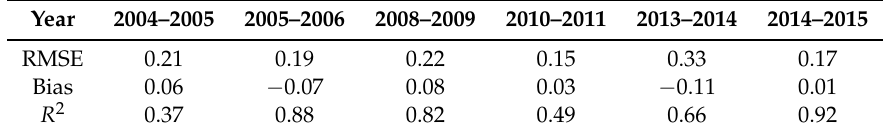
Table 3. RMSE, bias and correlation between simulated and observed snow depth at Oukaimeden (m).